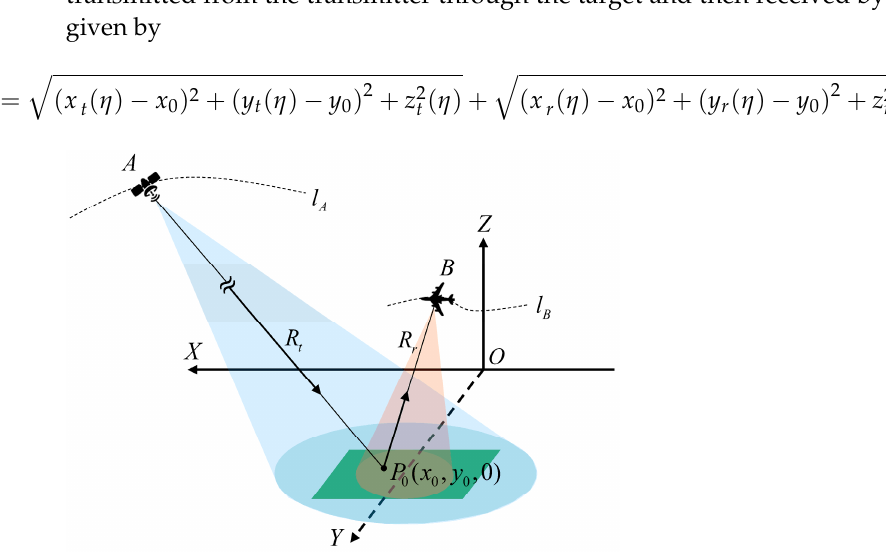
Figure 1. Imaging geometry of the GEO-UAV BiSAR system.